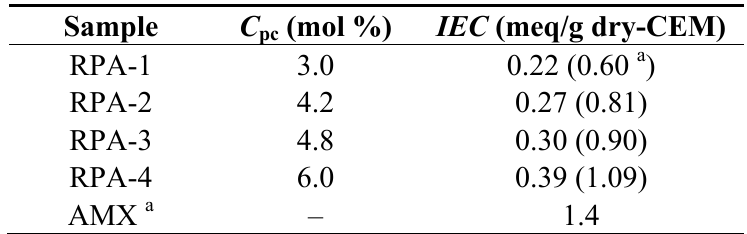
Table 1. The molar percentage of anion-exchange groups, C IEC , of the base membrane: The AEMs in this study were prepared from the base membranes: molar percentage of the anionic-exchange groups, C (RPA- X ) ( X = 1–4), changing GA concentrations.